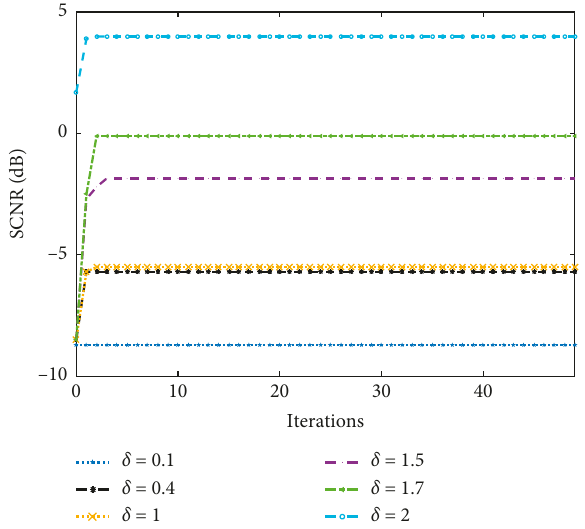
Figure 4: SCNR vs. number of iterations for phase quantized waveform.